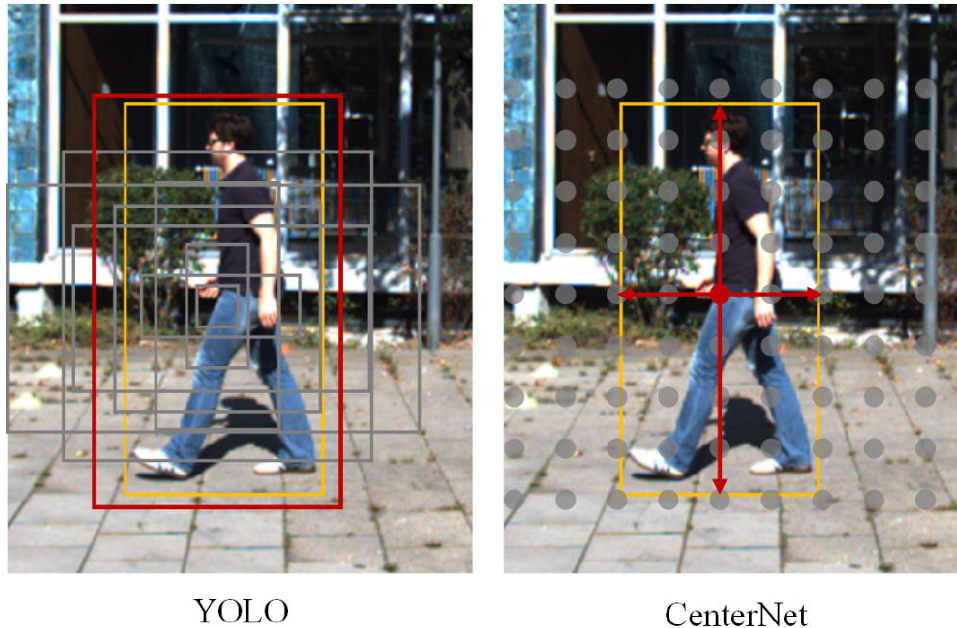
Figure 2. Sample imbalance problem for different detectors. Anchor-based detectors use many preset anchors to regress one object bounding box, and most of the anchors are negative samples. By contrast, anchor-free detectors use key points to regress the bounding box, and most of the key points are negative samples. Positive samples make up a small proportion of the total sample size.